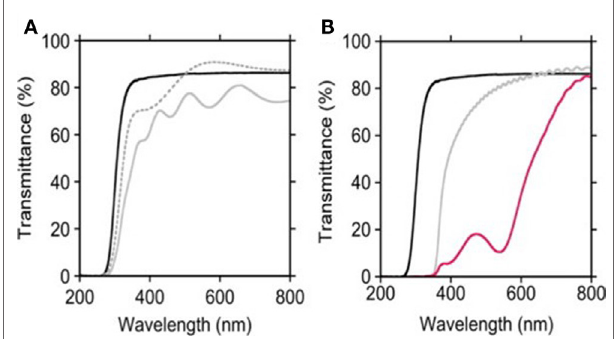
FiGURe 8 | Transmittance Uv–vis spectra of photoanodes of (A) graphene (black line), iTO (gray dashed line), and FTO (gray solid line) on glass; (B) graphene on glass (black line), TiO 2 on graphene (gray line), sensitized graphene–TiO 2 photoanode (red line) (Selopal et al., 2015). Copyright to Elsevier